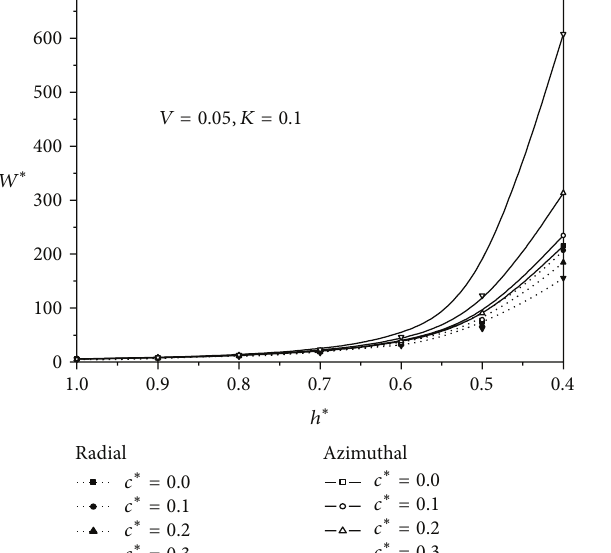
Figure 7: Dimensionless time 𝑡 ∗ versus non-Newtonian parameter 𝐾 for different 𝑐 ∗